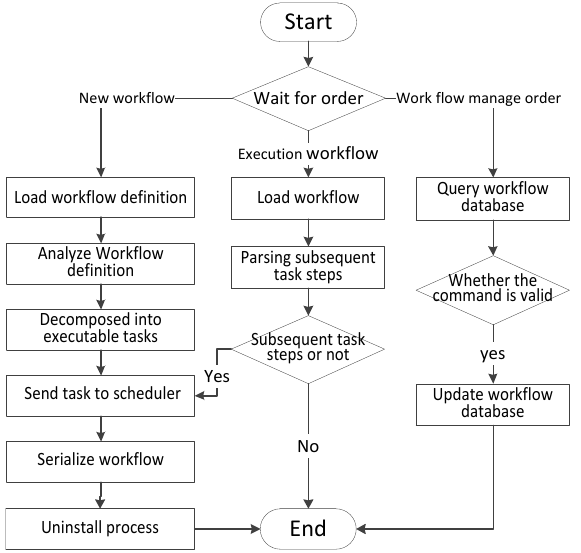
Figure 9. Process-driven engine